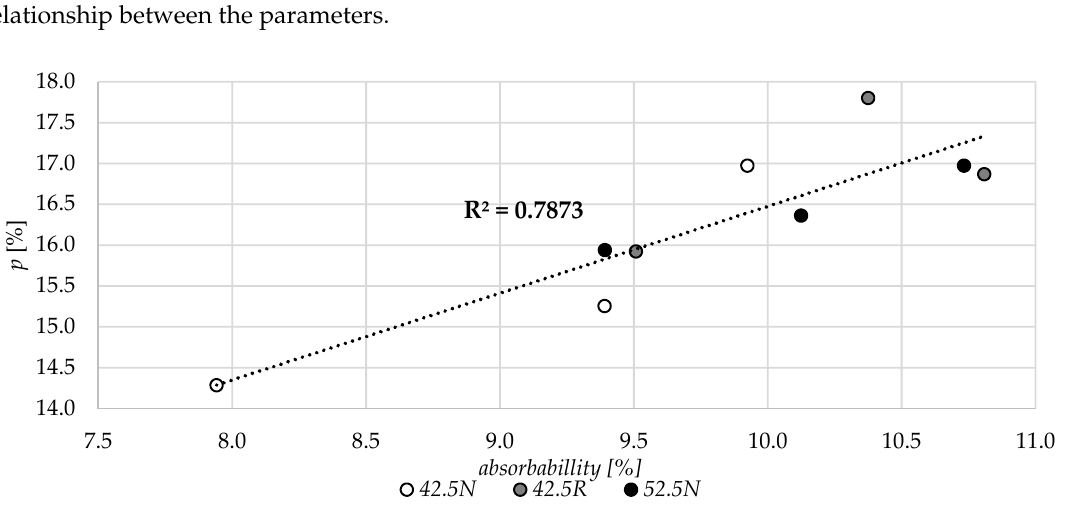
Figure 14. The relation between the water absorbability and total porosity, p (MIP).